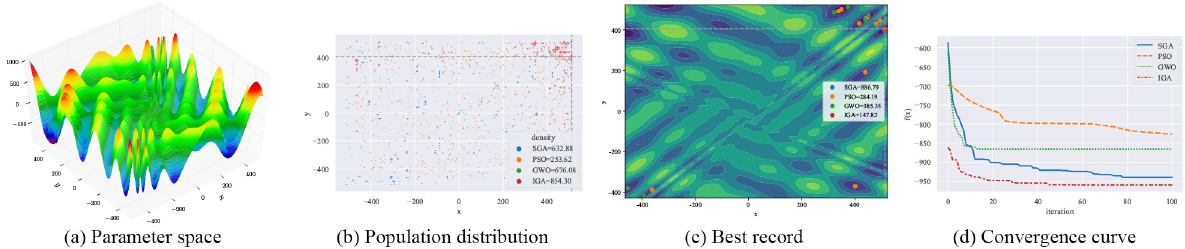
Fig 6. Qualitative results for the F15 function. (a) Parameter space. (b) Population distribution. (c) Best record. (d) Convergence curve.